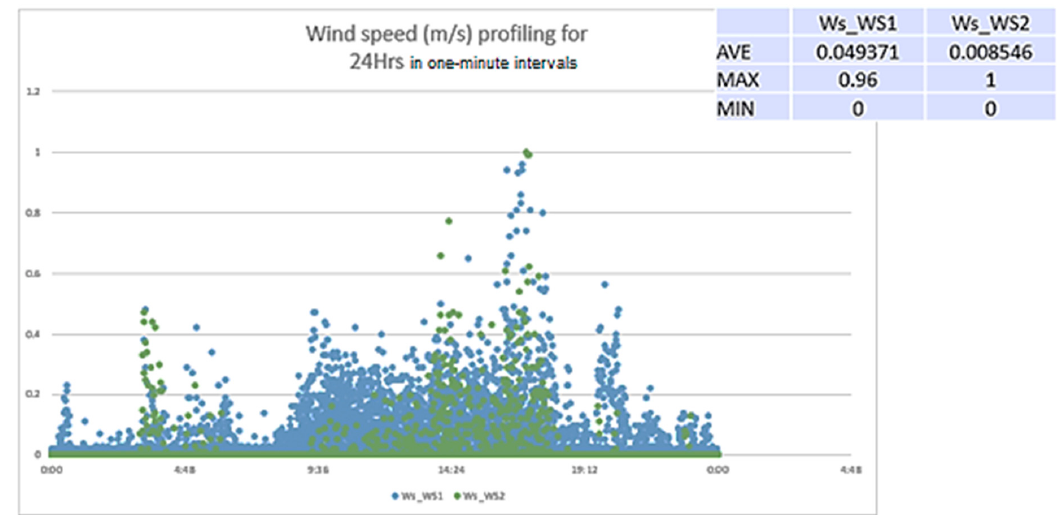
Figure 10. Wind speed